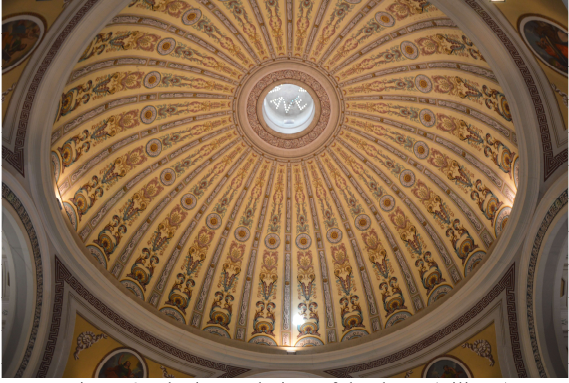
Figure 2. The internal view of the dome (Pilia